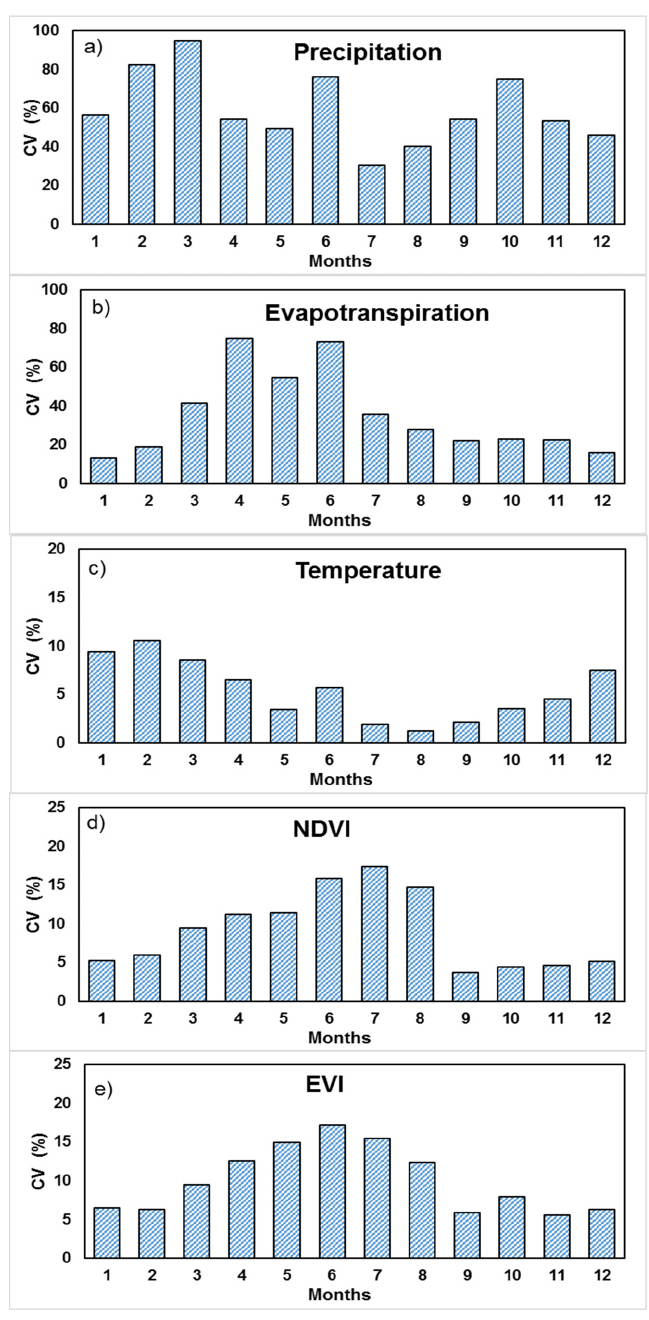
Figure 8. Mean temporal coefficient of variation (CV in %) plotted as a function of time (months) for ( a ) precipitation, ( b ) evapotranspiration, ( c ) temperature, ( d ) NDVI for the UKR Basin and ( e ) EVI. Note that 1–12 on the x -axis represent the months from January to December.